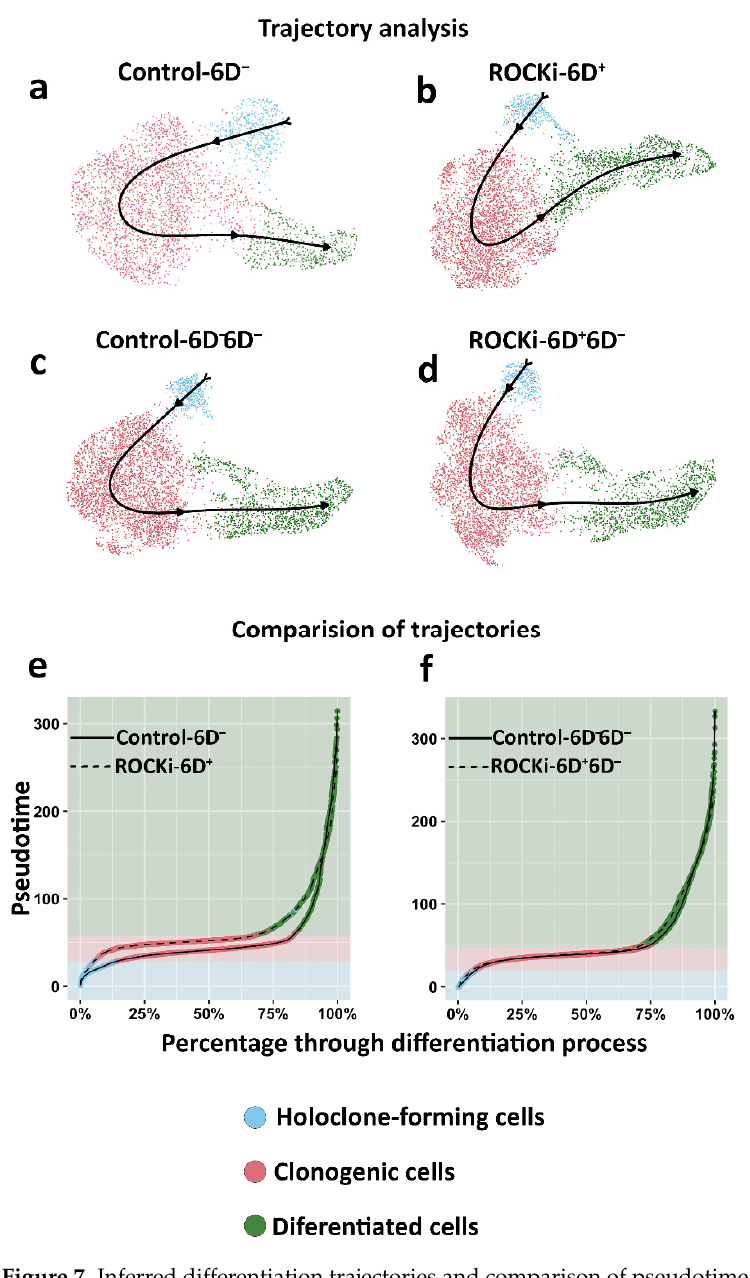
Figure 7. Inferred differentiation trajectories and comparison of pseudotime distributions. Slingshot was used to infer the differentiation trajectories of Control-6D − , ROCKi-6D + , Control-6D − 6D − , and ROCKi-6D + 6D − cells, respectively ( a – d ). Cell colour corresponds to the three clusters used as input to Slingshot, which correspond to the three cell types. Cumulative distributions of the pseudotimes of Control-6D − and ROCKi-6D + ( e ). Cumulative distributions of the pseudotimes of Control-6D − 6D − and ROCKi-6D + 6D − ( f ). The colour surrounding the line in ( e , f ) corresponds to the cluster of the cell at that point. The shaded portions in ( e , f ) correspond to the dominant cluster at each stage of differentiation.